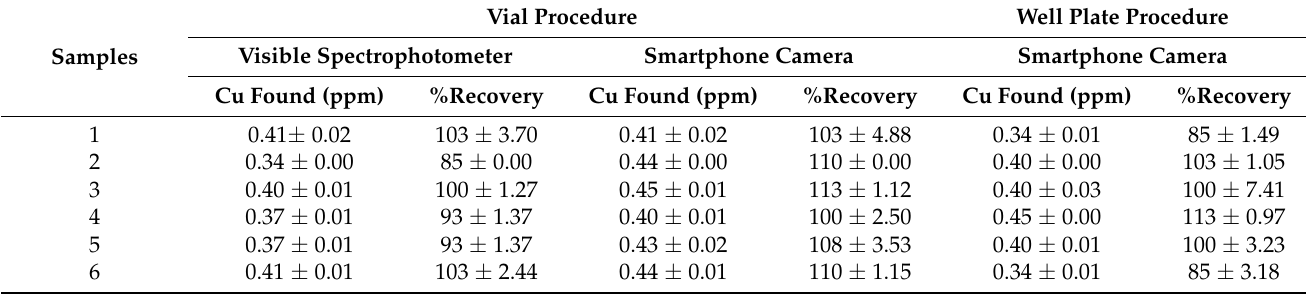
Table 2. Assay of Cu(II) in tap and drinking water samples spiked with 0.4 ppm Cu(II). Vial Procedure Well Plate Samples